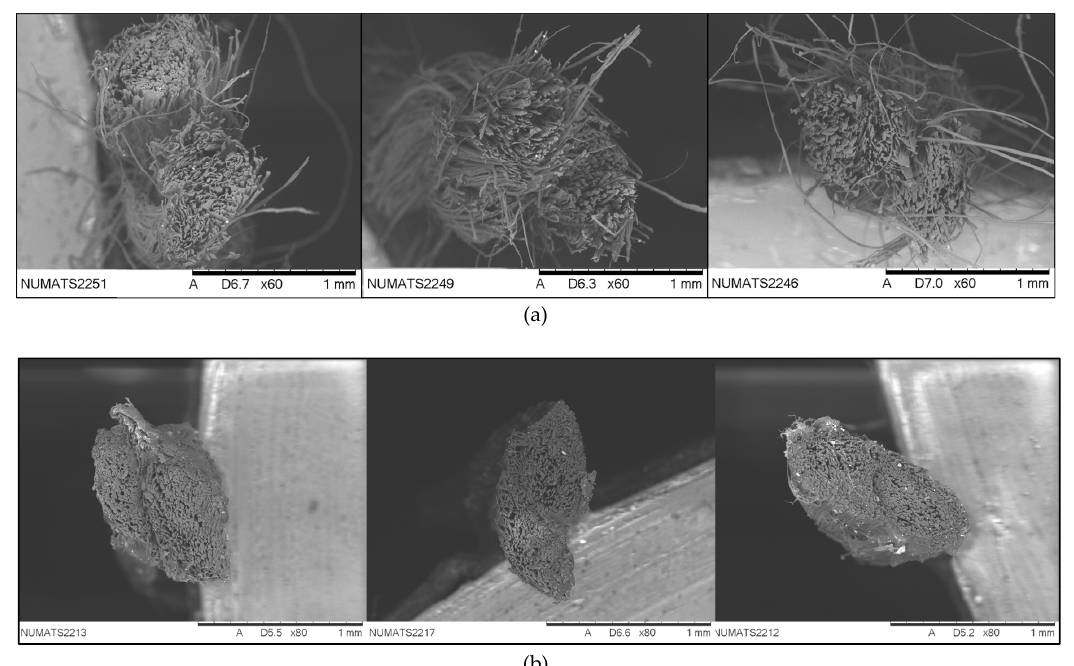
Figure 6. SEM images for ( a ) non-impregnated and ( b ) Impregnated representative samples subjected to pull-out tests.